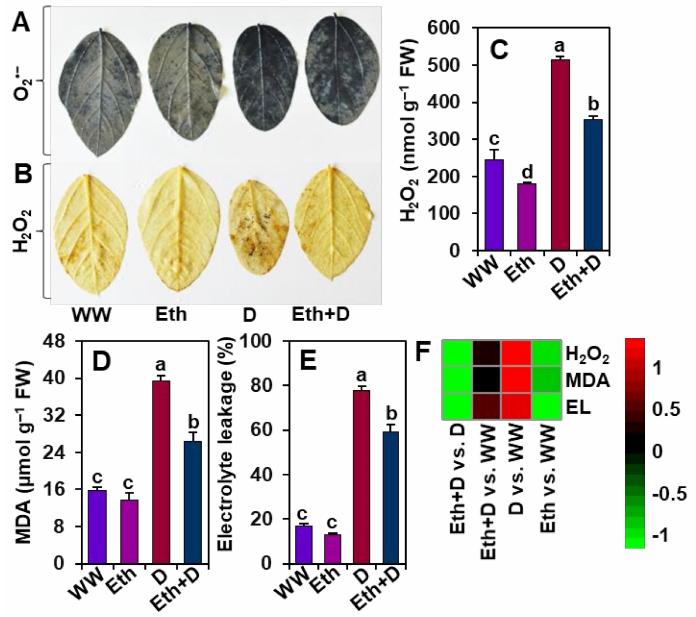
Figure 4. Effect of exogenously supplied 20-mM ethanol on ROS accumulation, and the